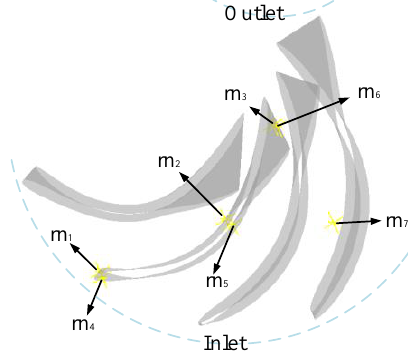
Figure 6. Runner monitoring point distribution